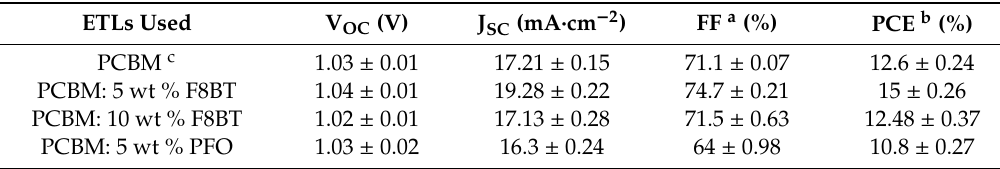
Figure 1. ( a ) The schematic diagram of the device architecture and energy levels of the device layers, ( b ) the chemical structure of poly(9,9-dioctyfluorene) (PFO) and poly(9,9-dioctylfluorene-co- benzothiadiazole) (F8BT), ( c ) the top SEM image of perovskite film and ( d ) the sectional SEM image of perovskite solar cells (PSC). Table 1. Summary of detailed performance parameters of